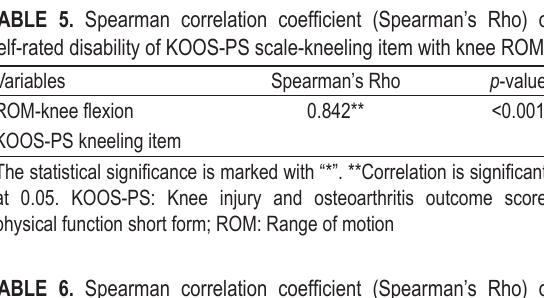
TABLE 6. Spearman correlation coefficient (Spearman’s Rho) of